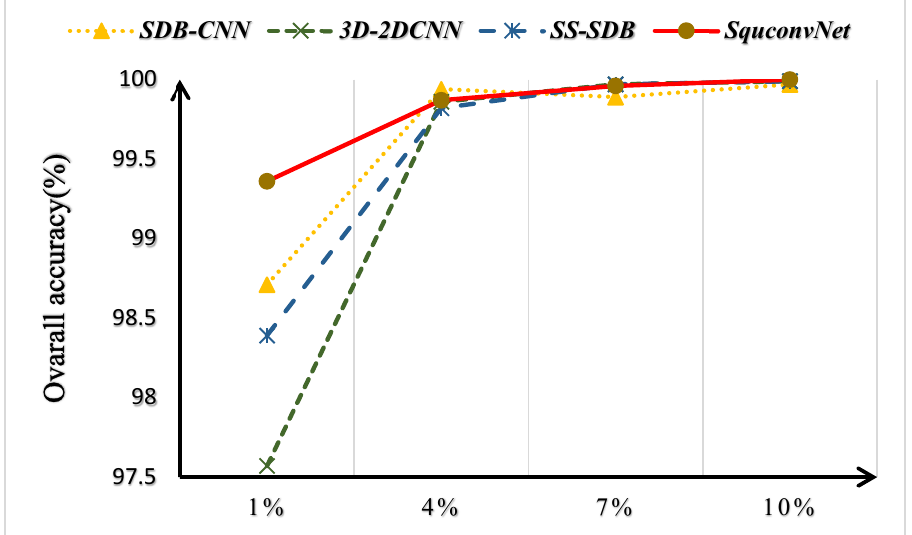
Figure 13. The Overall Accuracy of the different proposed models on the SA dataset at different training samples. Table 8. Ablation analysis of the proposed methods on the IP dataset with 30% labeled samples.